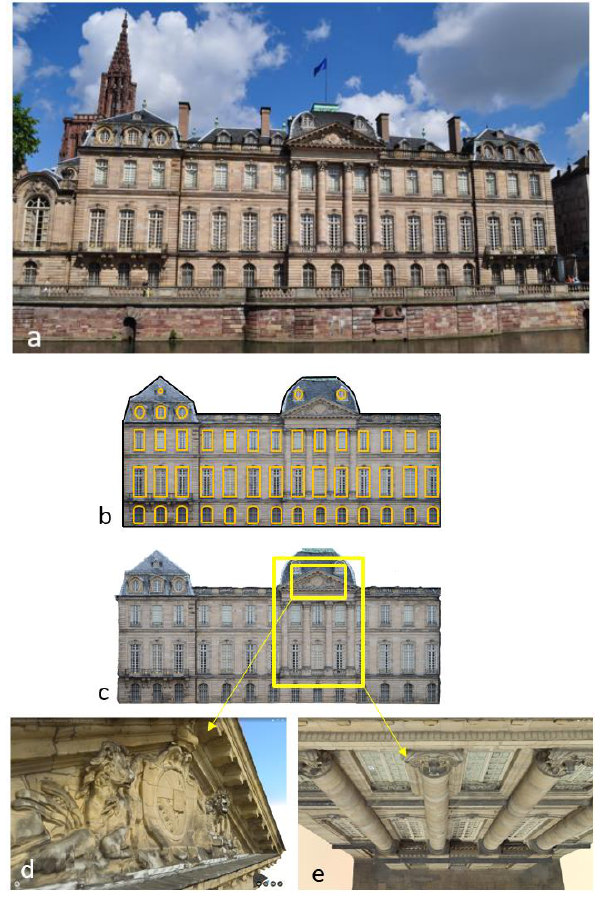
Fig. 8: The LOD for historic model taking a drawing and 3D modelling as example. LOD200 (b-c) represents the historic building facade with flat planes; LOD300 (b) provides the opening information; LOD400 provides detailed information such as accurate edge, the sculptures in the surface (d) and 3D columns, margins and windows